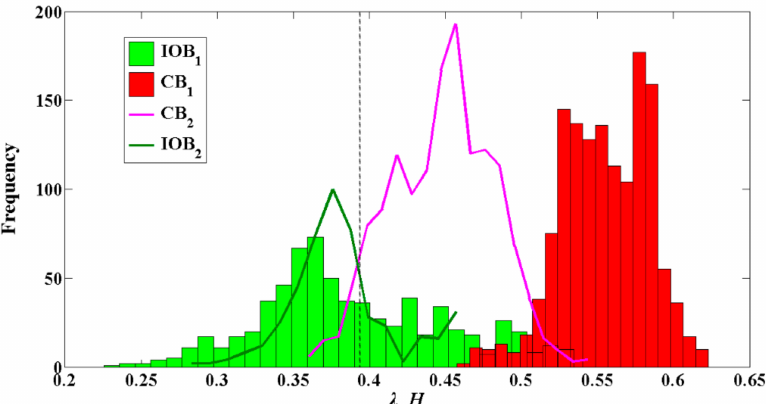
Figure 6. Comparison of histograms and histogram curves of parameter λ _H for the samples of intact oriented buildings and collapsed buildings. IOB 1 , CB 1 , CB 2 , IOB 2 represent No. 1 sample of intact oriented buildings, No. 1 sample of collapsed buildings, No. 2 sample of collapsed buildings and No. 2 sample of intact oriented buildings, respectively. The location of the black dotted line denotes the threshold value for separating the intact oriented buildings and the collapsed buildings.